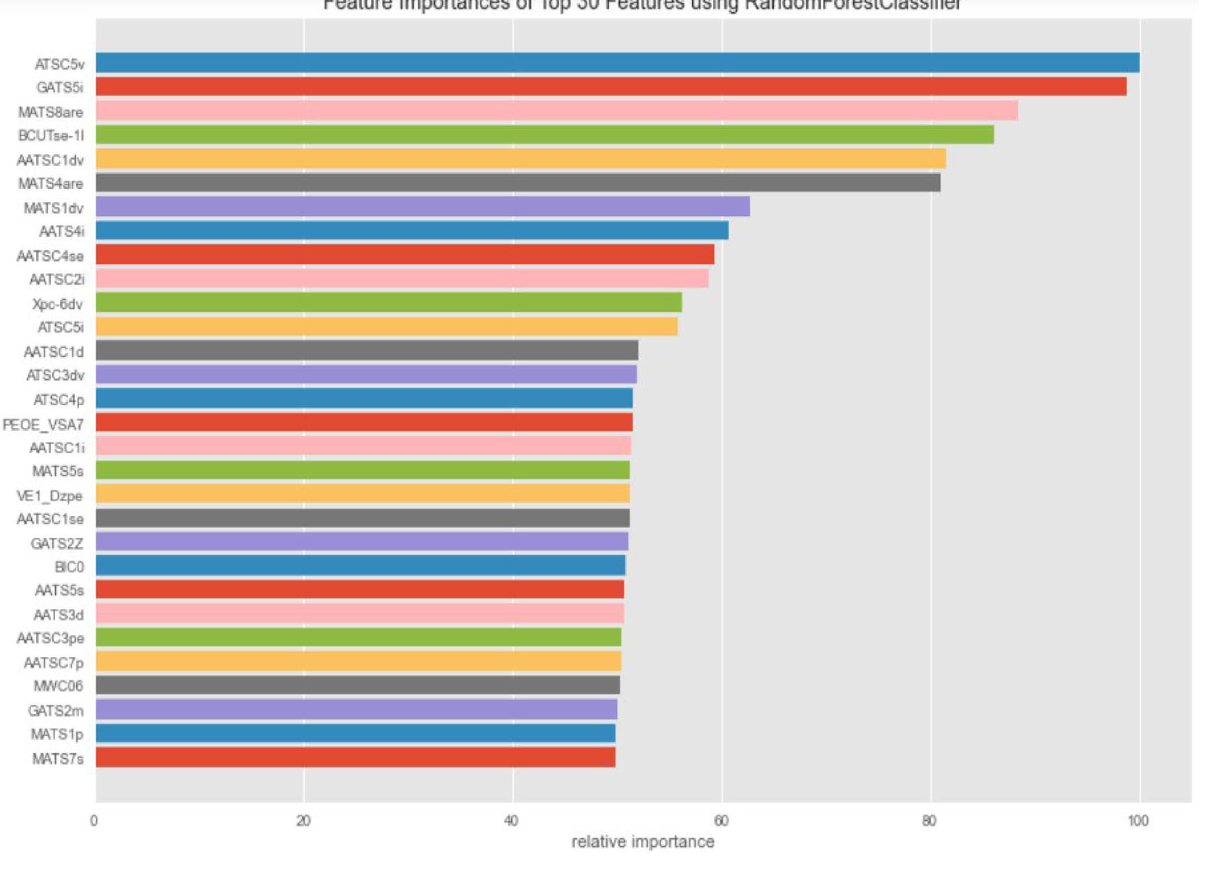
Figure 9. Feature importance based on closeness to the root node of decision trees in the forest computed on mordred featurization.